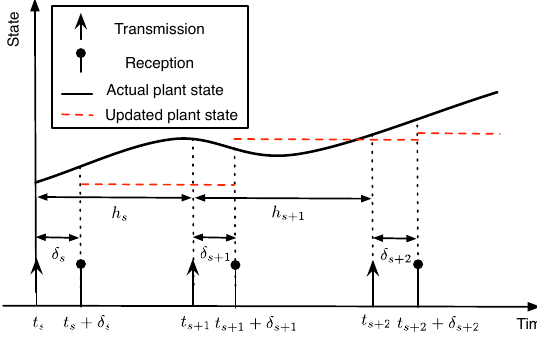
Figure 2. Illustration of a typical evolution of plant state updates at the